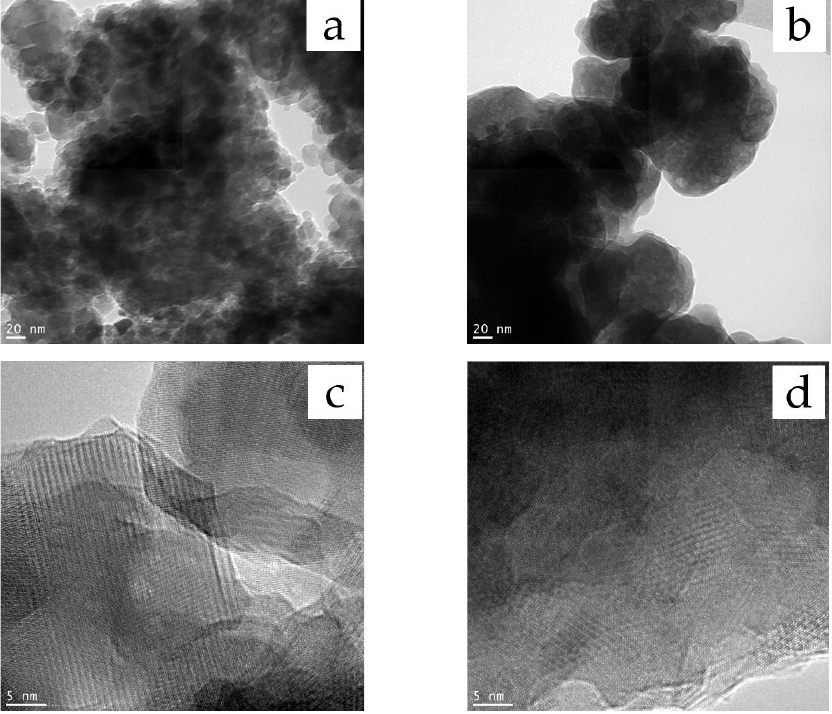
Figure 5. TEM ( a , b ) and HRTEM ( c , d ) images for HA ( a , c ) and 2.0-ZnSi-HA ( b , d ) samples.